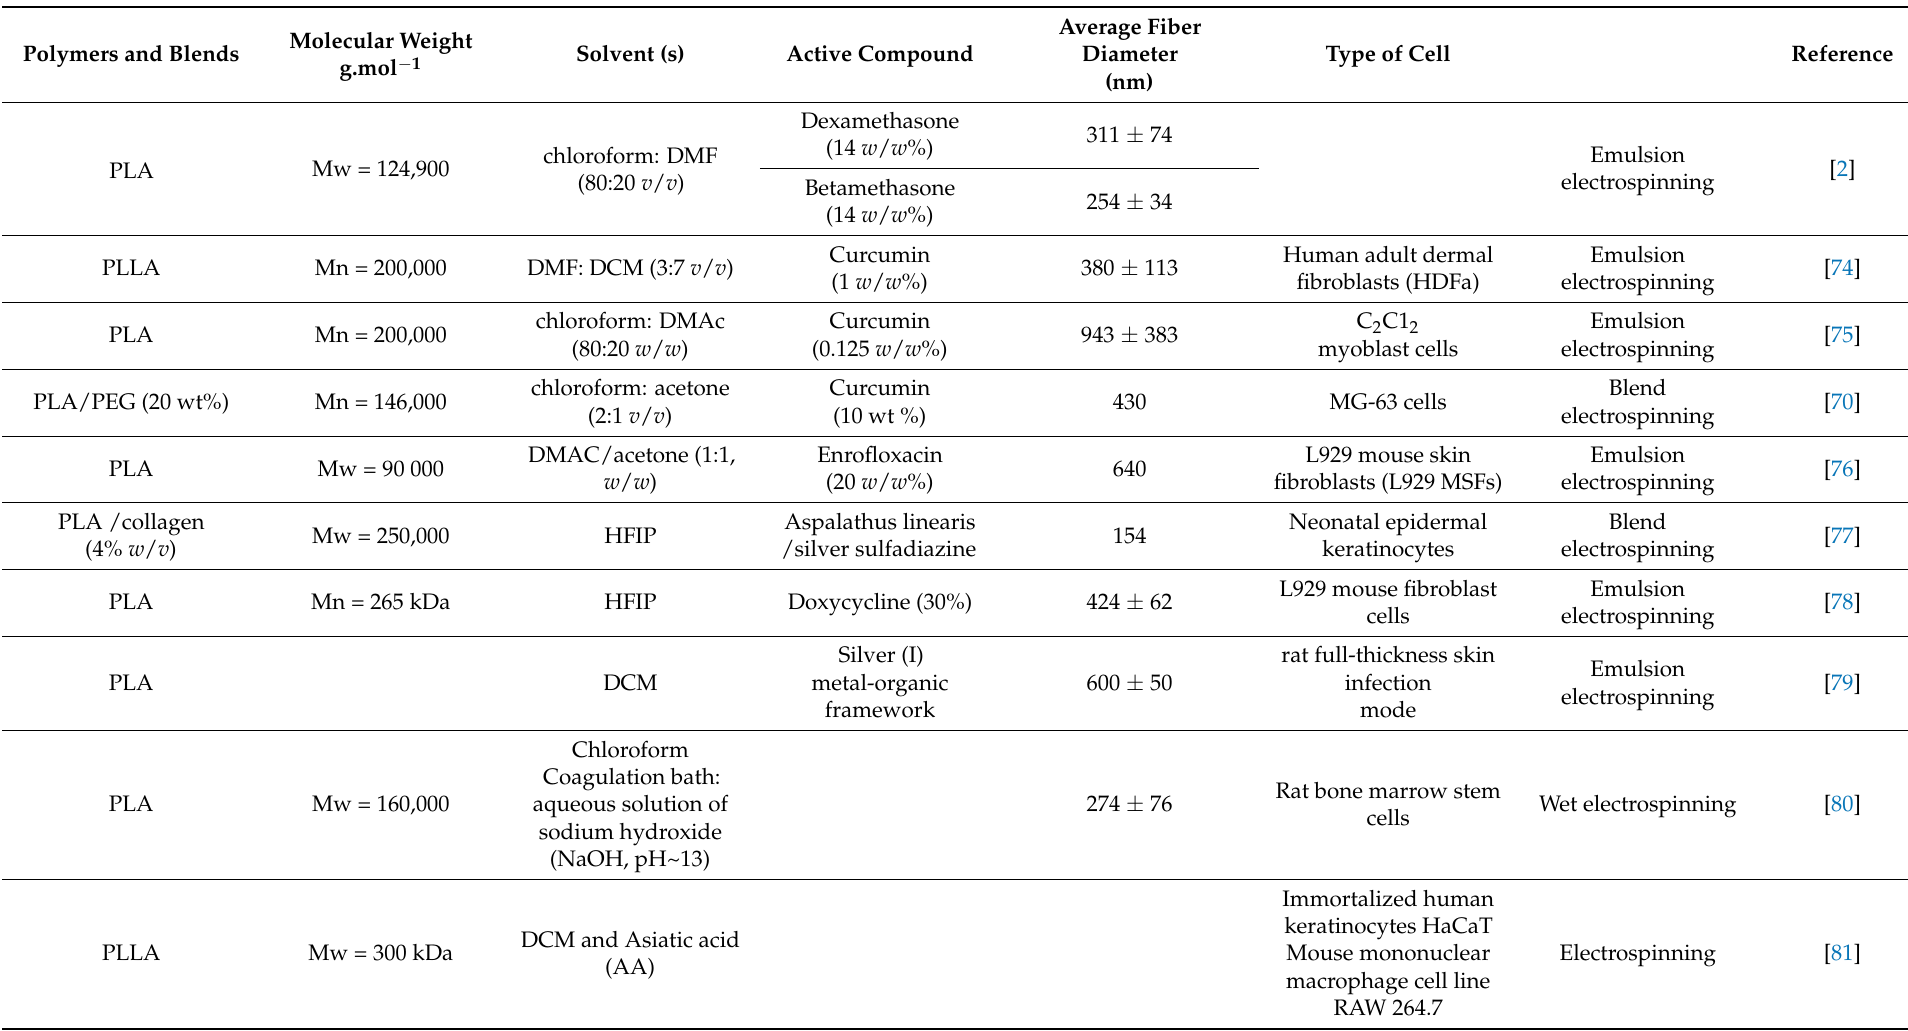
Table 1. Different studies in which electrospun PLA-based structures have been used as a wound